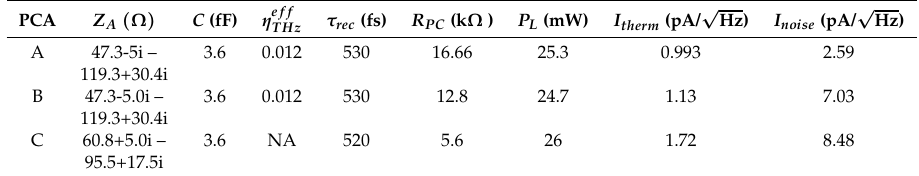
Table 1. PCA parameters for calculation of responsivity and noise-equivalent power (NEP). I noise is the measured current noise of the detectors while I therm is the ideal thermal noise floor.